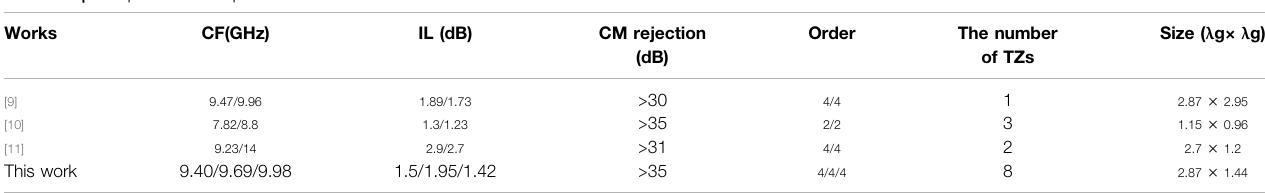
TABLE 1 | Comparisons with previous